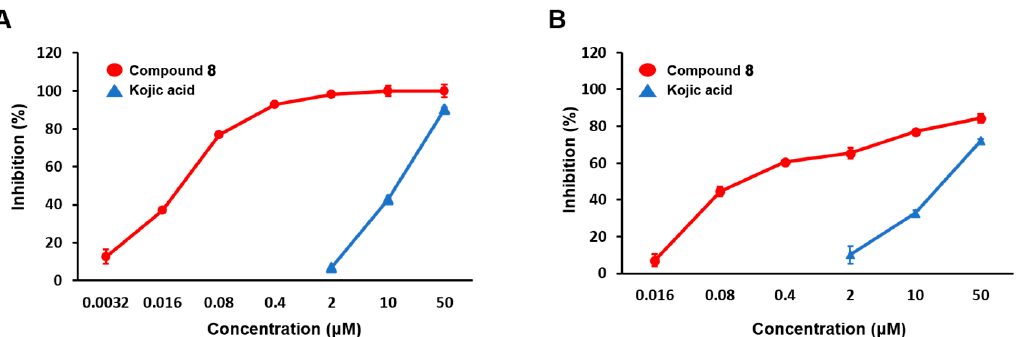
Figure 1. Concentration-dependent mushroom tyrosinase activity of compound 8 (red line) or kojic acid (blue line), using l -tyrosine ( A ) and l -3,4-dihydroxyphenyl-alanine ( l -DOPA) ( B ) as substrates. Data shown in the figure are mean ± SEM of three di ff erent experiments. Based on our earlier results, we reported that a potent tyrosinase inhibitor ( E )-2,4-dihydroxyphenyl-(thiophen-2-yl)prop-2-en-1-one showed a higher antityrosinase activity, with IC 50 values of 0.013 µ M for monophenolase and 0.93 µ M for diphenolase when compared to the other derivatives [24]. For these reasons, the present findings could be considered as a basis for further studies aiming at better defining the functional group of chalcone framework derivatives.